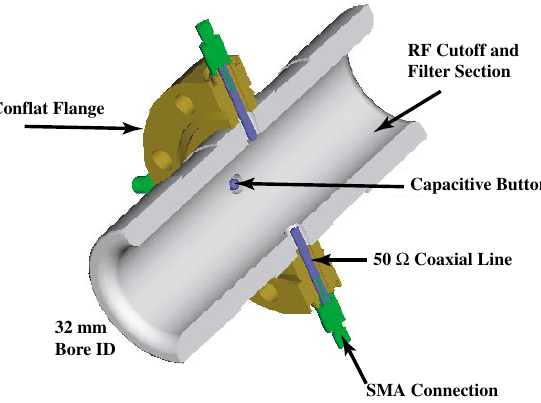
FIG. 9. (Color) Schematic of capacitive